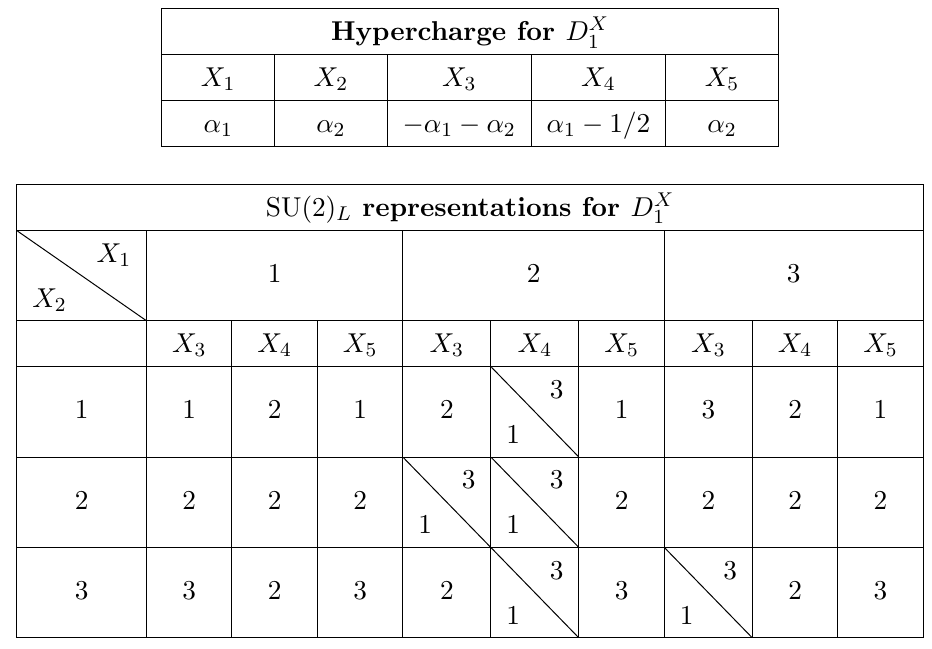
Table 1 . The SU(2) L and U(1) Y quantum numbers for the diagram D X (T1-i) of (cid:12)gure 8. Fixing 1 the charges of the two (cid:12)elds X 1 and X 2 , (cid:12)xes the possible charges of all the other X 3 (cid:0) 5 (cid:12)elds. The possible SU(2) L representations (up to triplets) of the (cid:12)elds X 1 and X 2 are given in the (cid:12)rst row and column of the second table. Their hypercharges are denoted by (cid:11) 1 and (cid:11) 2 , respectively, in the (cid:12)rst table. For the rest of the (cid:12)elds X 3 (cid:0) 5 we give all the possible hypercharges and SU(2) L representations (up to triplets). For simplicity, all the (cid:12)elds are colour singlets.